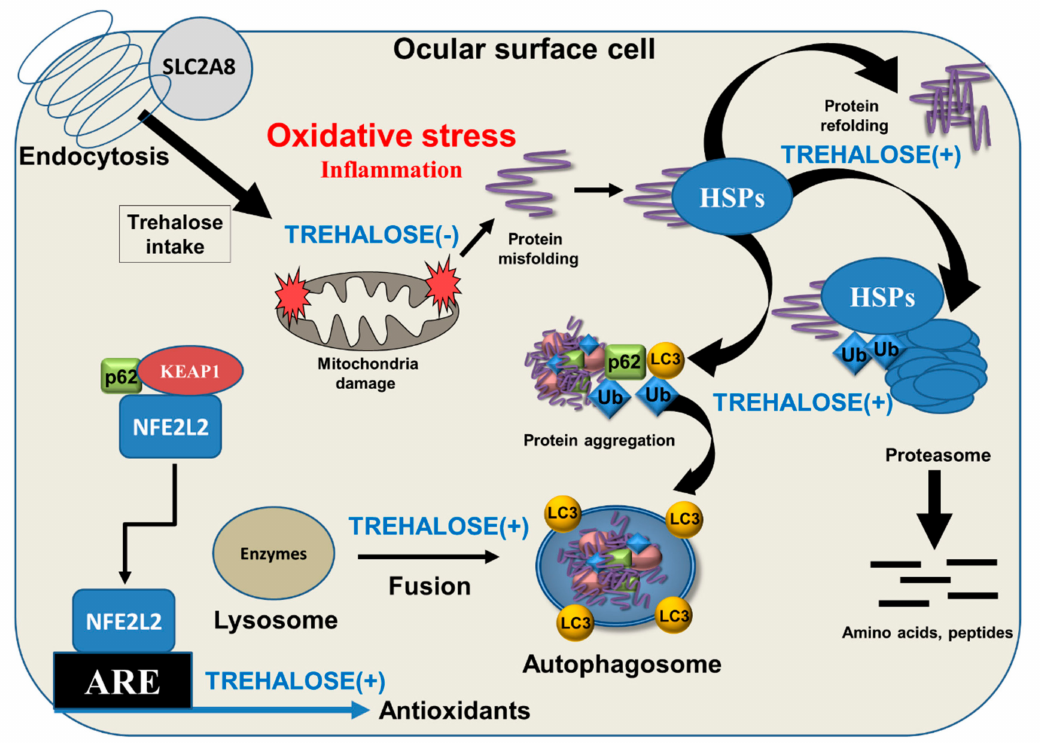
Figure 2. Schematic presentation of intracellular cytoprotective e ff ects of trehalose. Trehalose intake to cells is via endocytosis and under the control of Solute Carrier Family 2 Member 8 (SLC2A8). Ocular surface cells are constantly exposed to environmental oxidative stress, which may evoke mitochondrial damage, protein misfolding, aggregation, and inflammation. Trehalose helps protein refolding together with heat shock proteins (HSPs) and enhances ubiquitin (Ub)-mediated proteasomal and microtubule-associated protein 1A / 1B light chain 3 (LC3)-controlled autophagic clearance. LC3 and p62 / SQSTM1 have binding sites to Ub that direct the sealed material to autophagic degradation. Moreover, p62 / SQSTM1 regulates antioxidant production via transcription factor NFE2L2 released from NFE2L2-KEAP1 (kelch-like ECH-associated protein 1) and p62 / SQSTM1 complex, allowing its binding to the antioxidant response element (ARE) protein and promote the transcription of antioxidative proteins. All beneficial functions of trehalose (TREHALOSE ( + )) prevent oxidative-stress-induced inflammation (TREHALOSE